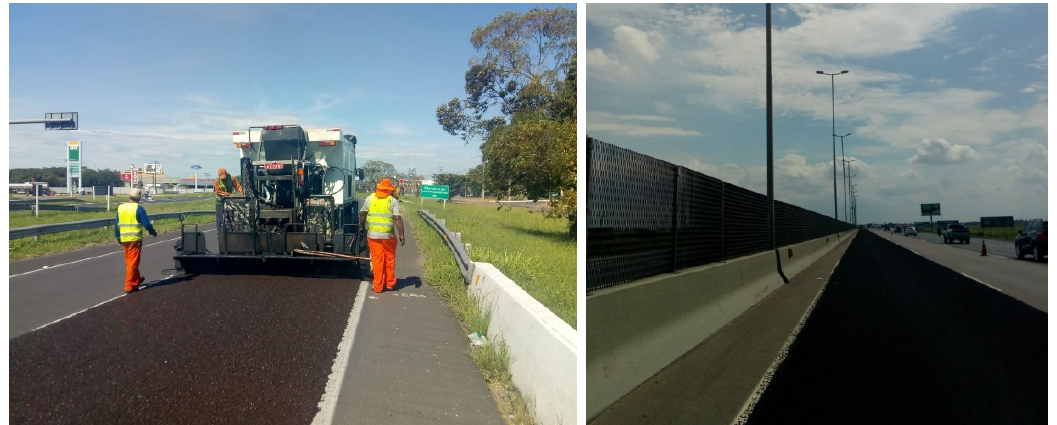
Figure 5. Microsurfacing on high traffic highway, during and after construction.